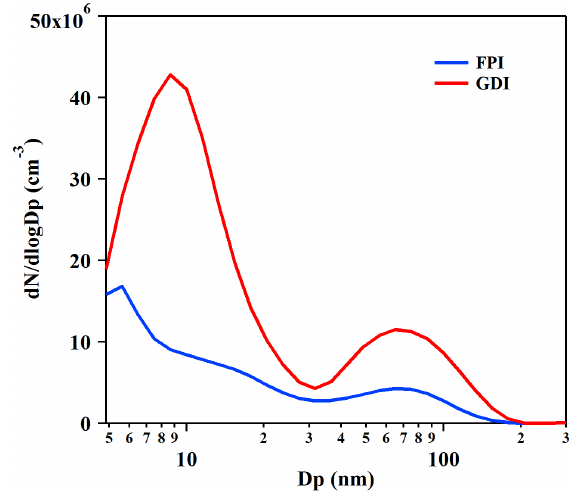
Figure 2. Number size distributions of primary PM emitted from the GDI (red line) and PFI (blue line) gasoline vehicles. The results are the average of particle number emissions from vehicles during a whole BJC, measured by DMS500 in the CVS system. The particles were heated to 150 ◦ C in the